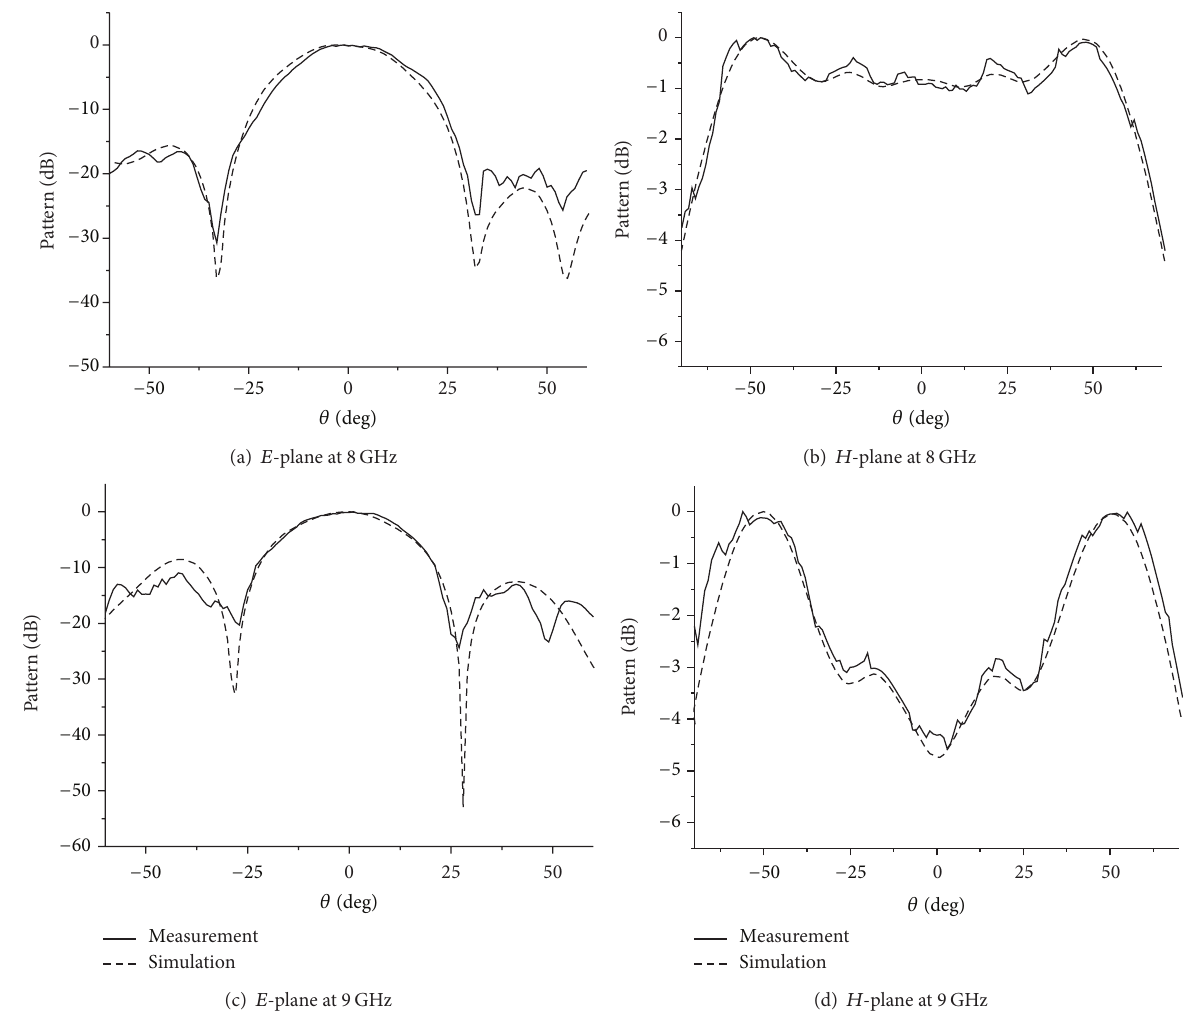
Figure 4: Measured and simulated radiation patterns of the center linear 8-element array at different frequencies. (a) E -plane at 8 GHz. (b) H -plane at 8 GHz. (c) E -plane at 9 GHz. (d) H -plane at 9GHz.